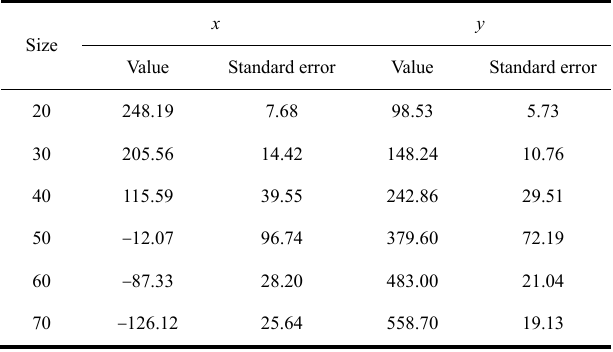
Table 1 Fitting parameters x and y for Ag 0.50 Fe 0.50 alloy with different sizes.